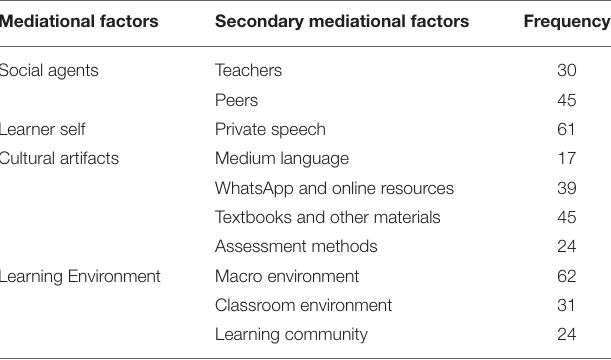
TABLE 3 | Mediational factors identified from the qualitative